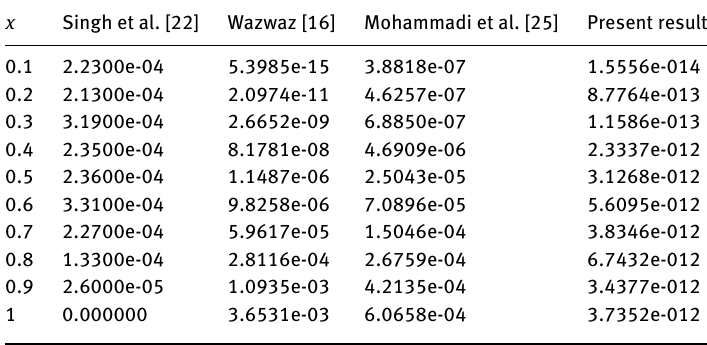
Table 4: Maximum errors E N for example 3 using N t = N x = 10, m = s = 3, and t = 0.5